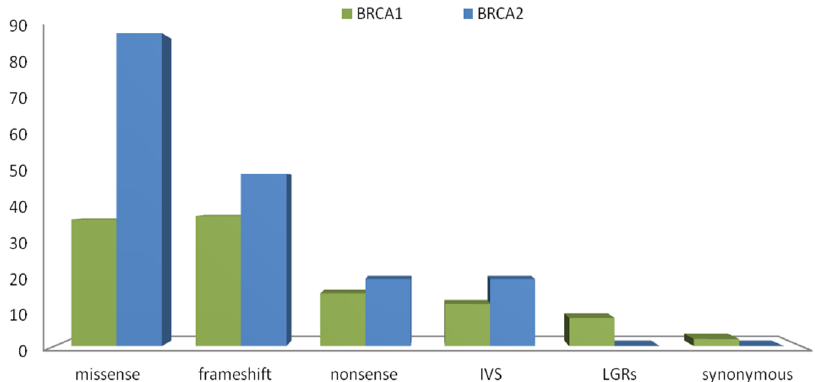
Figure 1. Variant spectrum in BRCA1 and BRCA2 genes. Histograms indicate the absolute number of all variants in BRCA1 and BRCA2, identified in our population.